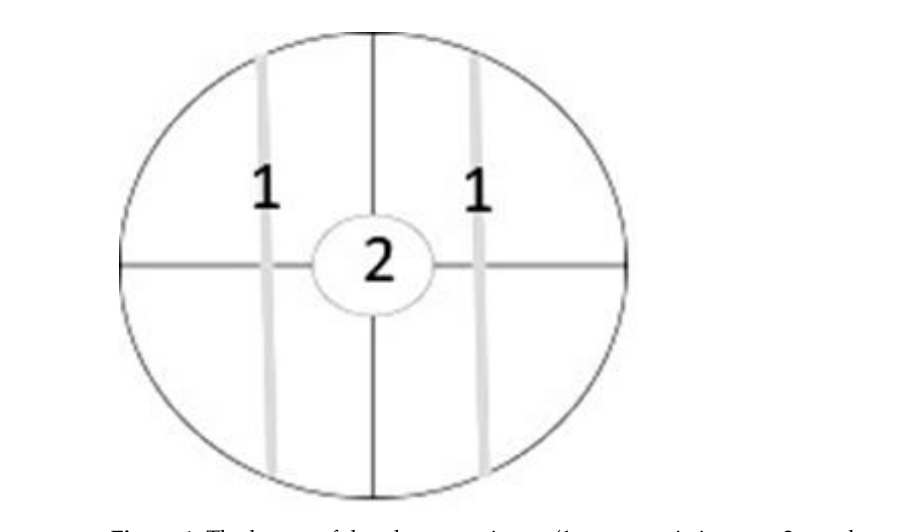
Figure 1. The layout of the plate experiment (1—antagonistic yeast; 2—pathogenic fungi). After six days, when any of the combinations were completely covered by pathogenic fungi mycelium., the diameter of the pathogenic fungi was measured. The percentage of growth inhibition was calculated: growth rate of control — growth rate of treated sam- ple)/growth rate of control × 100%.